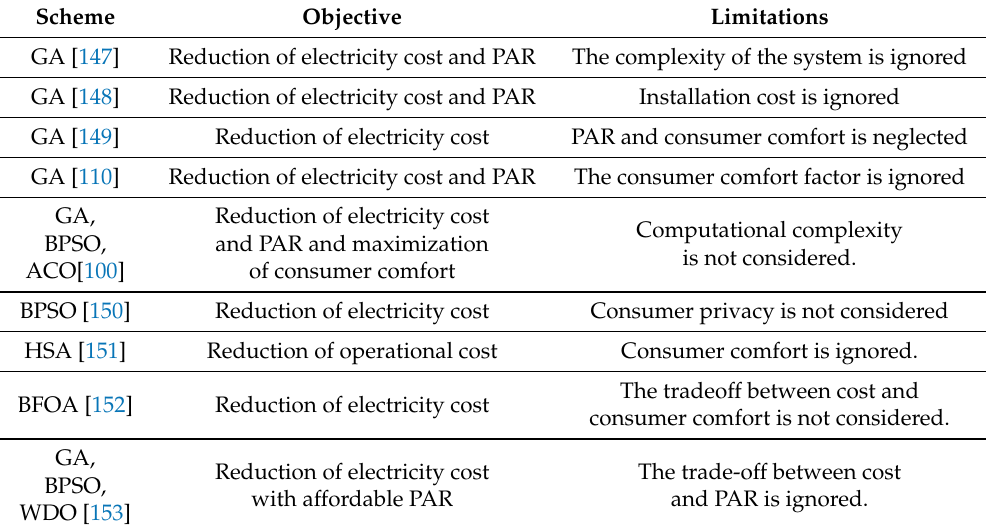
Table 7. Meta-heuristic